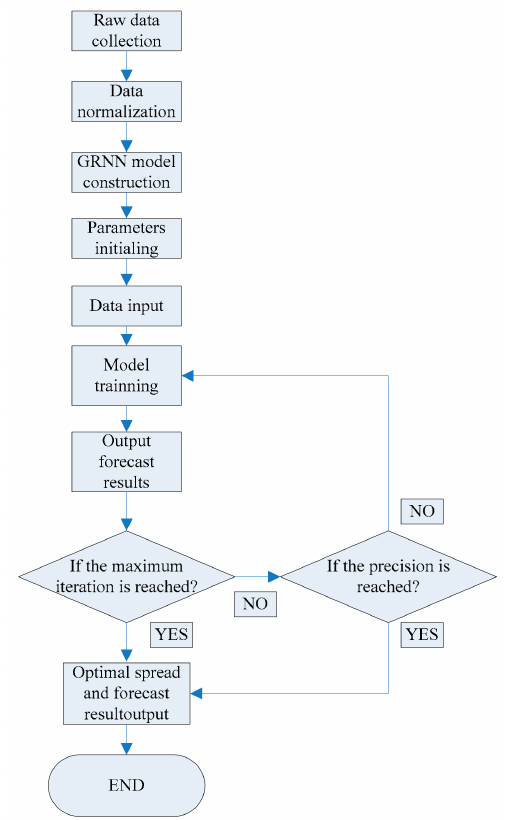
Figure 3. The flow chart of Generalized Regression Neural Network (GRNN)